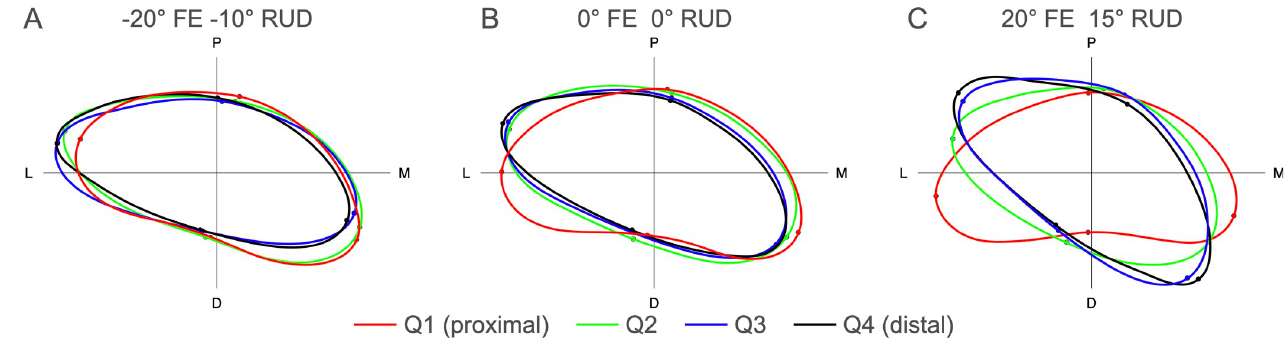
Fig 11. Illustration of the predicted mean (n = 10) twist along the carpal tunnel in neutral and with combined FE and RUD postures. Panel A demonstrates 20˚ extension with 10˚ of radial deviation where Q3 (blue) and Q4 (black) exhibit slight external rotation relative to Q1 (red) and Q2 (green). Panel B demonstrates neutral posture (0˚ FE and 0˚ RUD) where Q2, Q3, and Q4 are internally rotated relative to Q1. Panel C demonstrates 20˚ flexion with 15˚ of ulnar deviation where Q2 is internally rotated relative to Q1 and Q3 and Q4 are further internally rotated relative to Q2 and